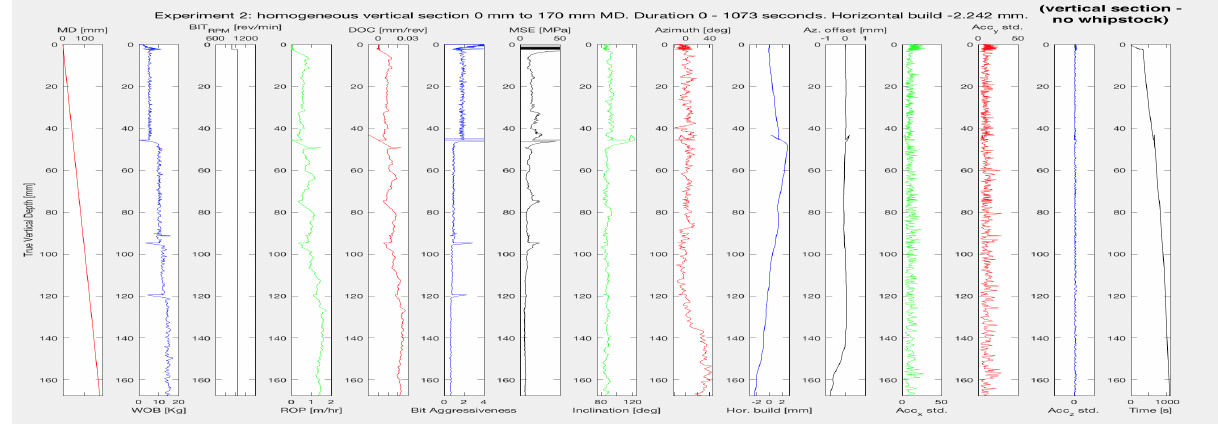
Figure 7: Experiment 2: Well log representing rig performance when drilling with downhole motor in vertical pilot hole section for 170 mmTVD to later RIH with whipstock. Riser is used to ensure verticality.